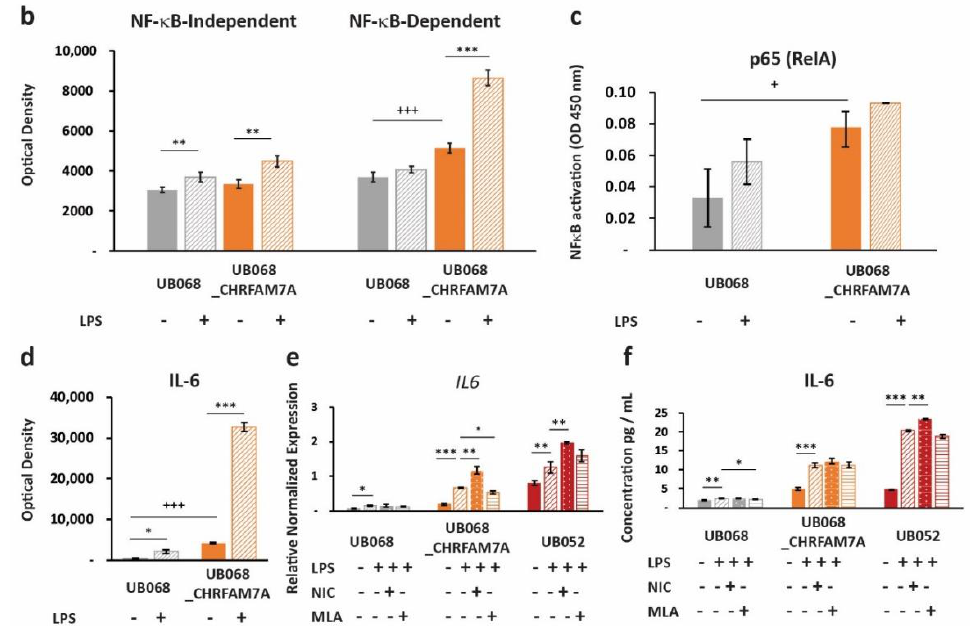
Figure 4. Immune surveillance of PAMPs: ( a ) Human cytokine profiler assay of MGL-conditioned media (24 h) from UB068 and UB068_CHRFAM7A lines at baseline (left) and after 24 h of LPS stimulation (right). Note the robust increase in the IL-6 expression in response to the LPS (1 µg/mL) treatment in UB068_CHRFAM7A. ( b ) Densitometric analysis of NF-κB-independent (left) and NF-κB -dependent (right) cytokines in the LPS treated and untreated MGL cells. Note the difference in the baseline expression level of the NF-κB-dependent cytokines between the two lines. The LPS’s effect on the NF-κB-independent and NF-κB-dependent cytokines is depicted in the non-carrier (UB068) and carrier (UB068_CHRFAM7A) lines. NF-κB-independent cytokines demonstrated similar responses in both lines, while a marked NF-κB-dependent gain of function occurred in the carrier (UB068_CHRFAM7A line). Data are presented as mean ± SD. *** p < 0.001—difference in the baseline between the UB068 and UB068_CHRFAM7A lines; ** p < 0.01, *** p < 0.001 ( t -test)—difference in the cytokine expression between the LPS-treated and LPS-untreated MGL cells. ( c ) Quantitative analysis of the NF-κB binding in nuclear extracts of the MGL cells derived from the UB068 and UB068_CHRFAM7A lines treated with LPS (1 µg/mL, 3 h). Data are presented as mean ± SD. * p < 0.05 ( t -test). ( d ) Densitometric analysis of IL-6 in media of MGL cells treated with LPS (1 µg/mL, 24 h). Data are presented as mean ± SD. *** p < 0.001—difference in the IL-6 baseline between the UB068 and UB068_CHRFAM7A lines; * p < 0.05, *** p < 0.001 ( t -test)—difference in the IL-6 expression between the treated and untreated MGL cells. RT-qPCR ( e ) and ELISA ( f ) in the non-carrier (UB068) and carrier (UB068_CHRFAM7A and UB052) lines with pharmacological modulation. Data are presented as mean ± SD. * p < 0.05, ** p < 0.01, *** p < 0.001—difference in the LPS-induced inflammatory response compared to non-treated controls, with and without pharmacological modulation.2.5. CHRFAM7A Affected the NF-κB Translocation Dynamics, Resulting in Innate Immune Activation.